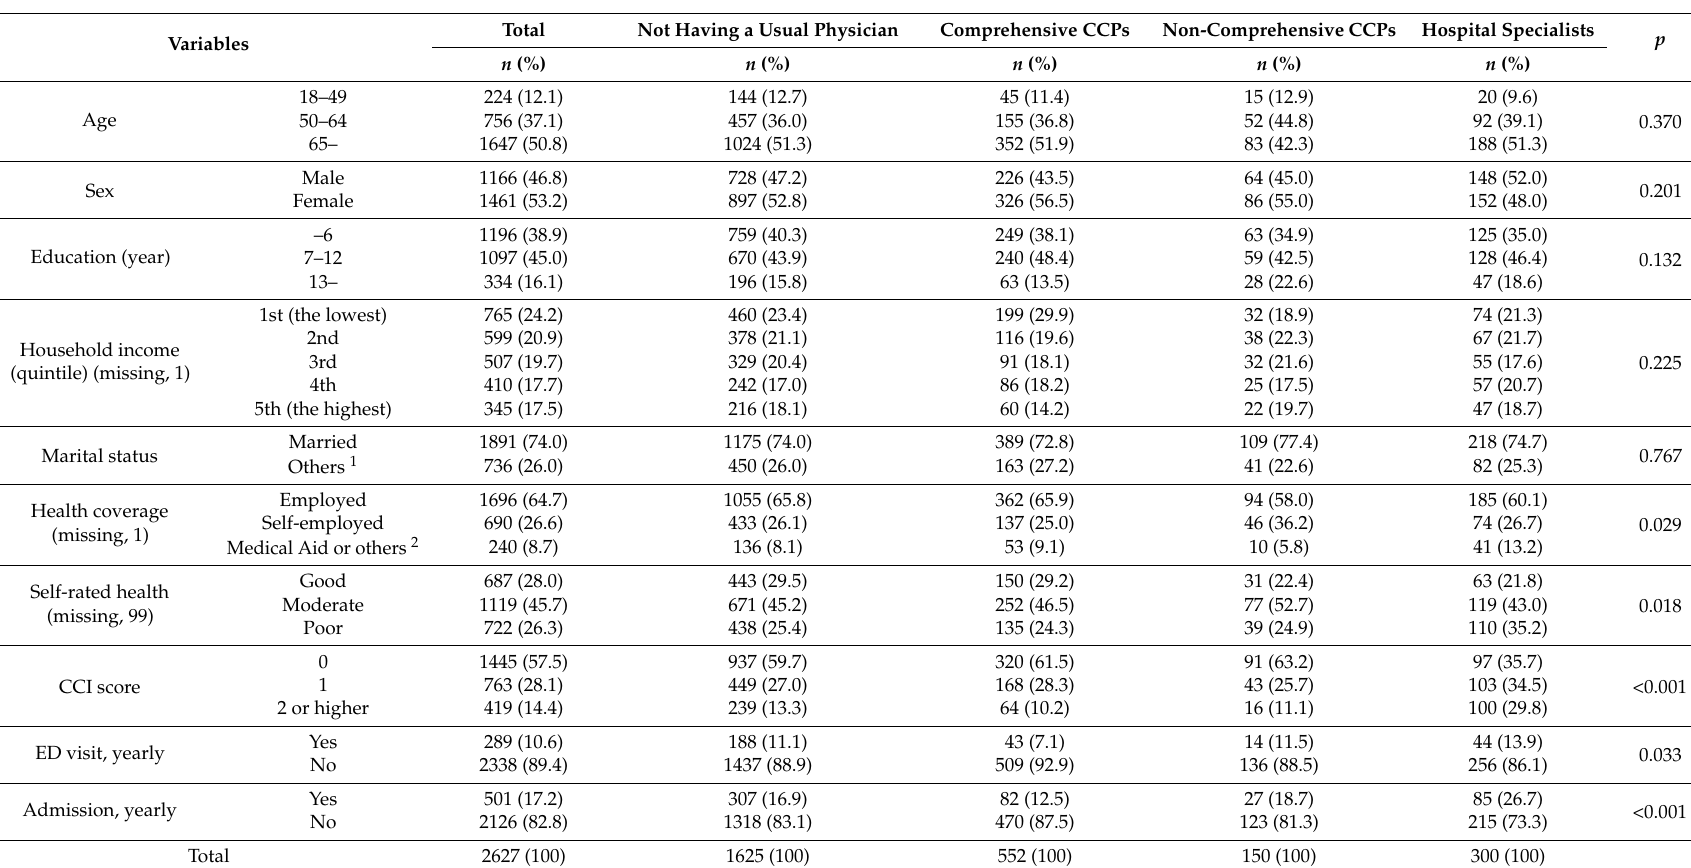
Table 2. Sociodemographic characteristics by types of physicians as a usual source of care in adults ( ≥ 18 years) with hypertension—based on 2013 Korea Health Panel